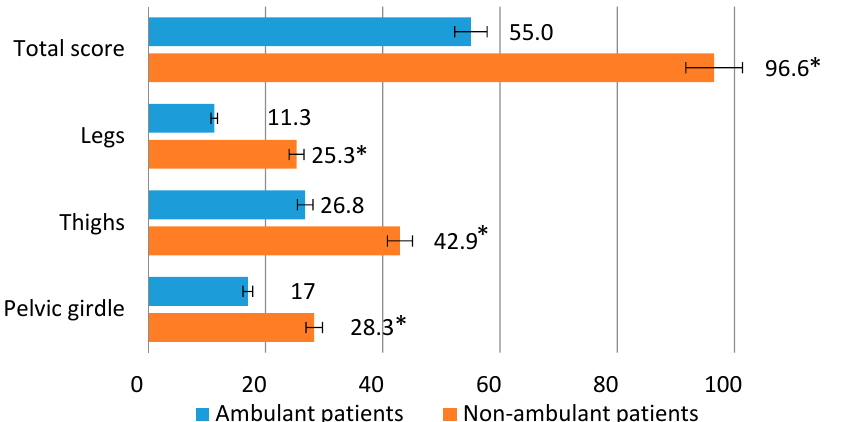
Figure 2. The average Mercuri score for patients with ability and inability to walk independently. * * p ≤ 0.01.